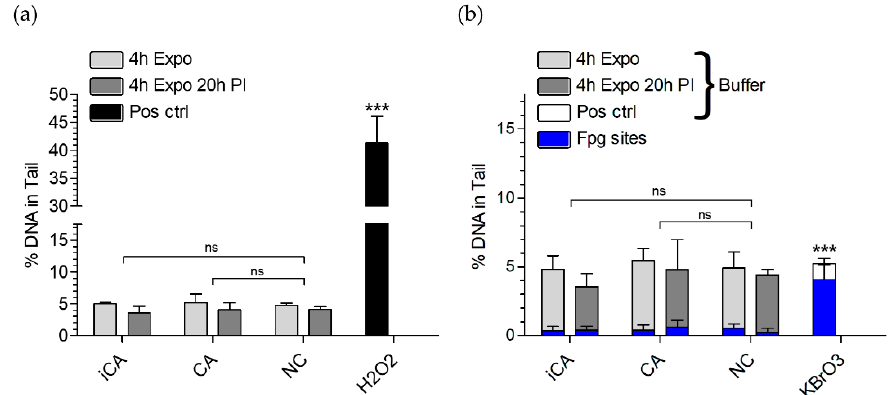
Figure A4. Effect of the new ALI exposure system with its different installations on A549 cells upon 24 h exposure to clean air (n = 2). ( a ) Percentage cell viability normalized to the NC, and (b) percent- age cytotoxicity compared to the NC measured by normalization to the total LDH release (2% Triton X-100 positive control). ( c ) Live cell imaging with 5 µg/mL H 33342 to stain the nuclei (blue) and 2.5 µg/mL propidium iodide (red) to selectively stain dead cells. iCA = independent clean air, NC = negative control. Installations: F = Filter; D + F = Denuder + Filter; D = Denuder; No installation= ( − ).